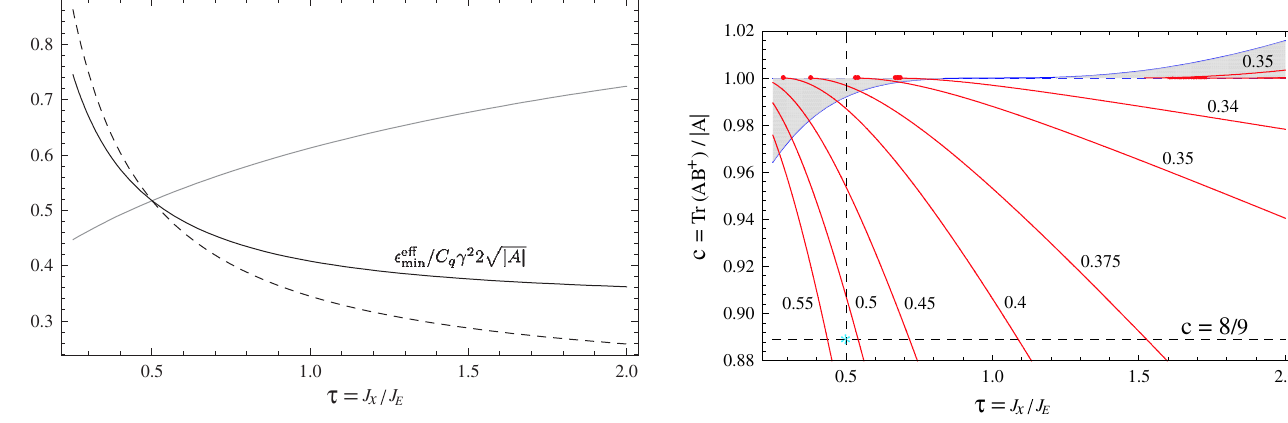
FIG. 4. Change of the minimum effective emittance with FIG. 6. (Color) Contours of minimum effective emittance ffiffiffiffiffiffiffi p damping partition variation for uniform dipoles. The solid, =C (cid:2) 2 2 (cid:1) eff p ffiffiffiffiffiffiffiffiffiffiffiffiffiffiffiffiffiffiffiffiffi j A j (red curves) over the (cid:12) - c parameter space. q min =J F min = 4 j A j gray, and dashed curves show, respectively, p ffiffiffiffiffiffiffiffiffiffiffiffiffiffiffiffiffiffiffiffiffi p x , ffiffiffiffiffiffiffiffiffiffiffiffiffiffiffiffiffiffiffiffiffi The horizontal and vertical black dashed lines give c ¼ 8 = 9 F min = 4 j A j F min = 4 j A j =J j J , and and (cid:12) ¼ 1 = 2 , respectively. x . x ¼ 1